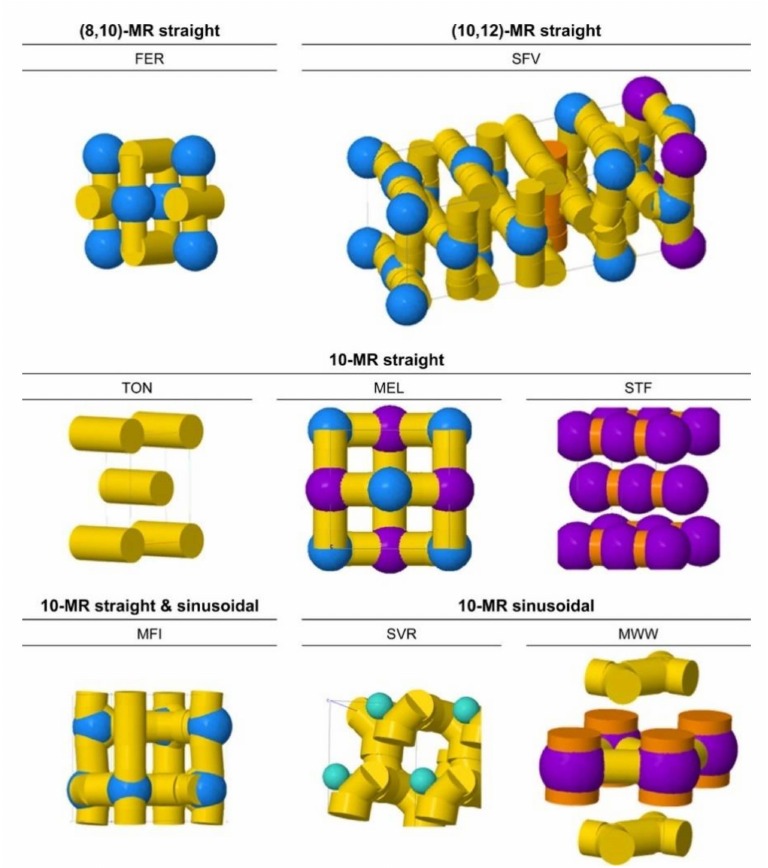
Figure 2. Characterizations of 10-membered ring (MR) zeolites with different channel and cavity topologies (generated with the ZEOMICS web tool [49]). Channels are represented in yellow (<6 Å diameter) and orange (>6 Å diameter), while cages are illustrated as green (<6 Å diameter), blue (6–8 Å diameter), and purple (>8 Å diameter) spheres. Reprinted with permission from [9]. Copyright 2016, American Chemical